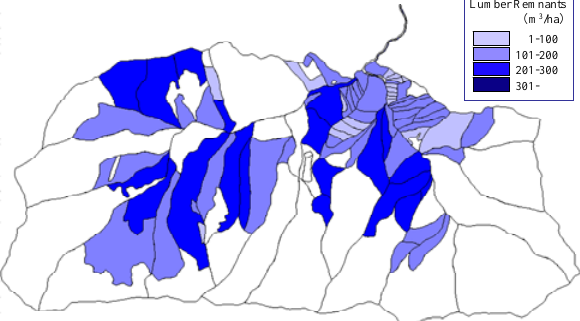
Figure 13. Result Map of Lumber Remnants